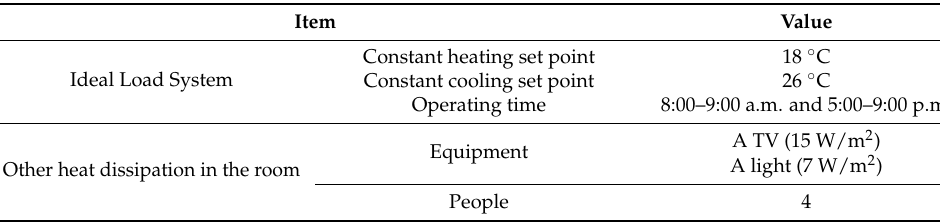
Table 4. Settings in the numerical simulation [39,42].